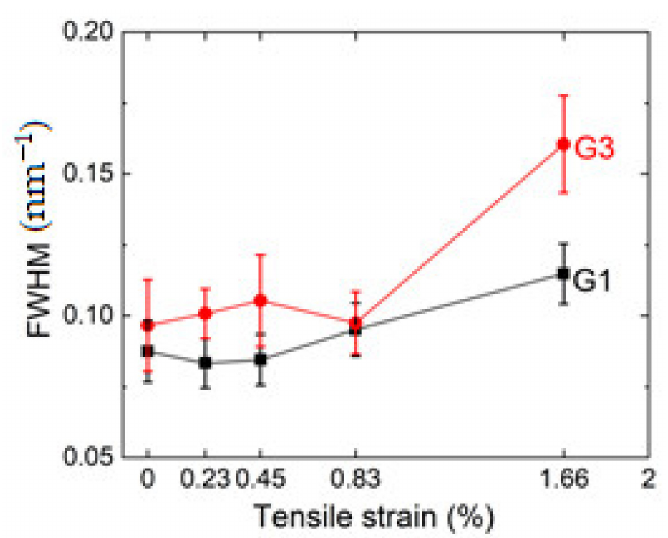
Figure 7. The average values of the full width at half the maximum (FWHM) of the diffraction intensity profile from energy scans in grains G1 and G3 during tensile loading. The error bars show standard deviations. The 0.2% offset yield point strain for Al is about